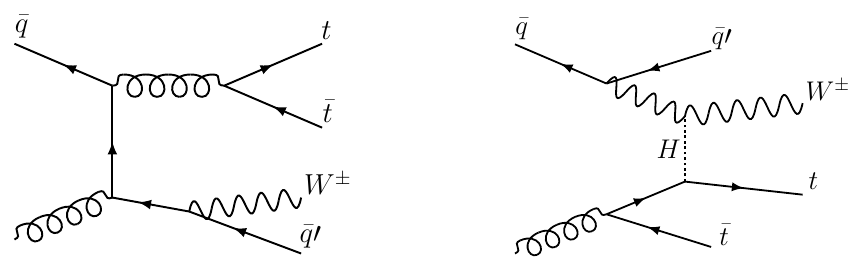
Figure 1 . Representative diagrams for the (cid:22) qg ! t (cid:22) tW (cid:6) (cid:22) q 0 real-emission amplitudes. The left diagram leads to log 2 ( p 2 ( t (cid:22) t ) =m 2 ) terms in the NLO 1 contribution. The right diagram shows an T W example of tW ! tW scattering and contributes to the NLO 3